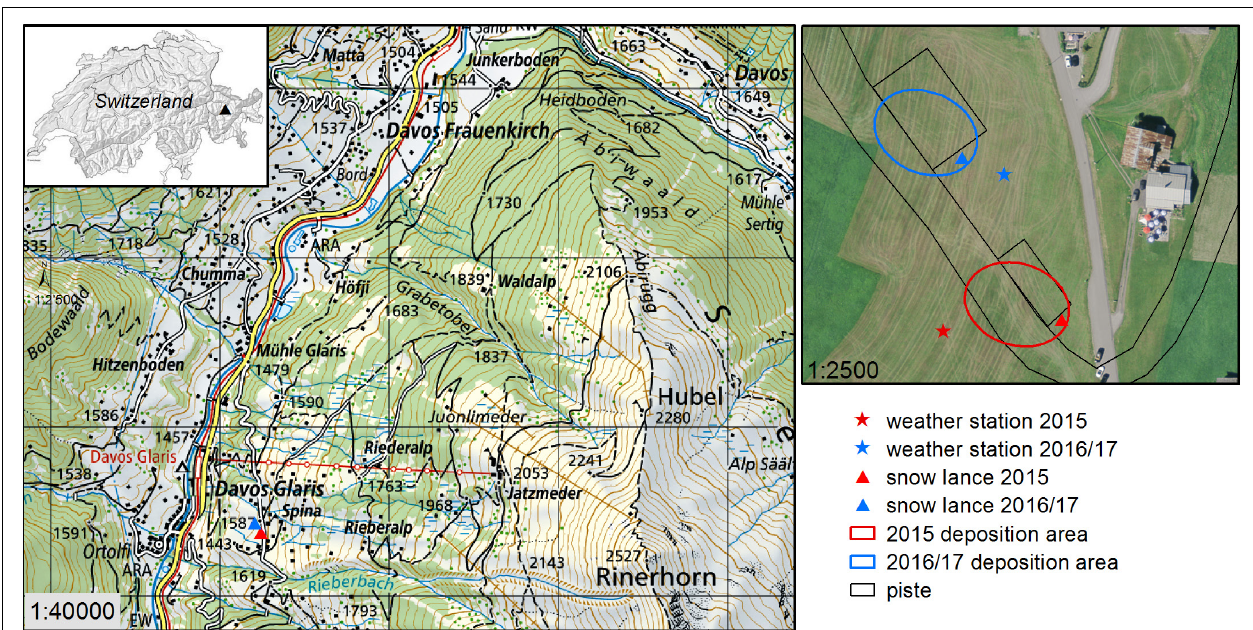
FIGURE 1 | Topographic map and aerial photography of the study site at the Rinerhorn. Base maps: Swiss Map and swissimage© 2019 swisstopo (5704 000 000).